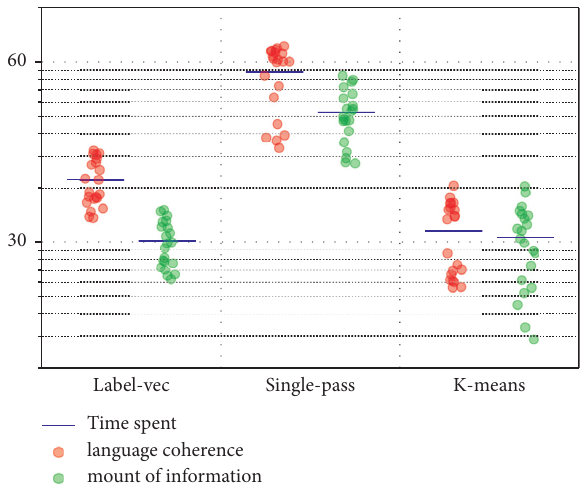
Figure 8: Comparison of the amount of information and language coherence detected by different algorithms.